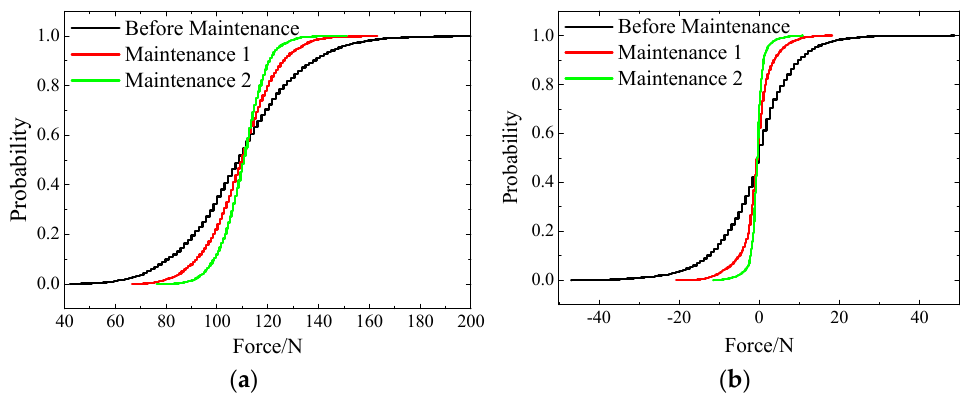
Figure 15. The effect of the maintenance suggestions (on contact force): ( a ) normal contact force; ( b ) friction force. Table 4. Statistical values of the acceleration of pantograph strip.